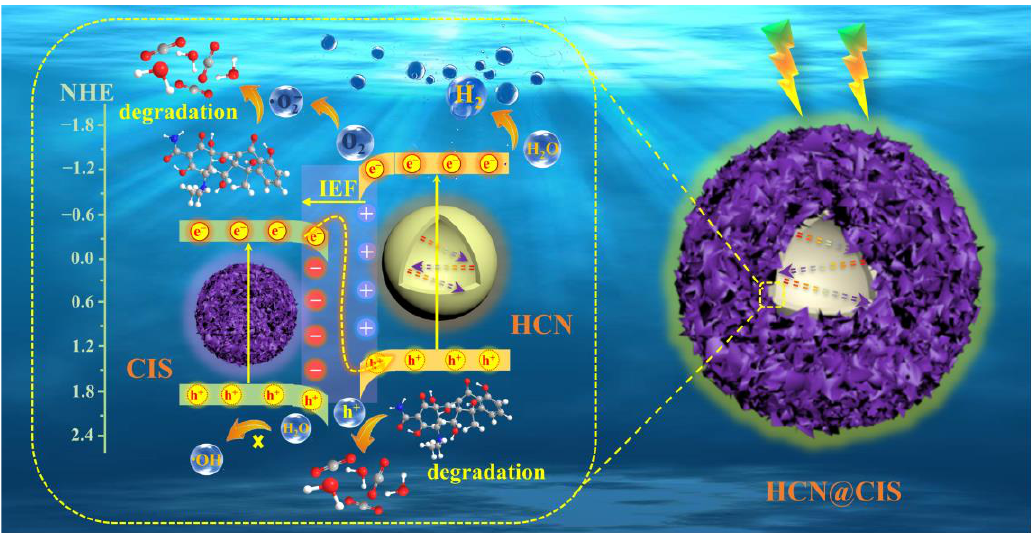
Figure 6. Transient photocurrent density curves ( a ), EIS Nyquist plots ( b ), and TRPL decay spectra ( c ) of HCN, CIS, and HCN@CIS. EPR signals of HCN, CIS, and HCN@CIS in light ( d ).